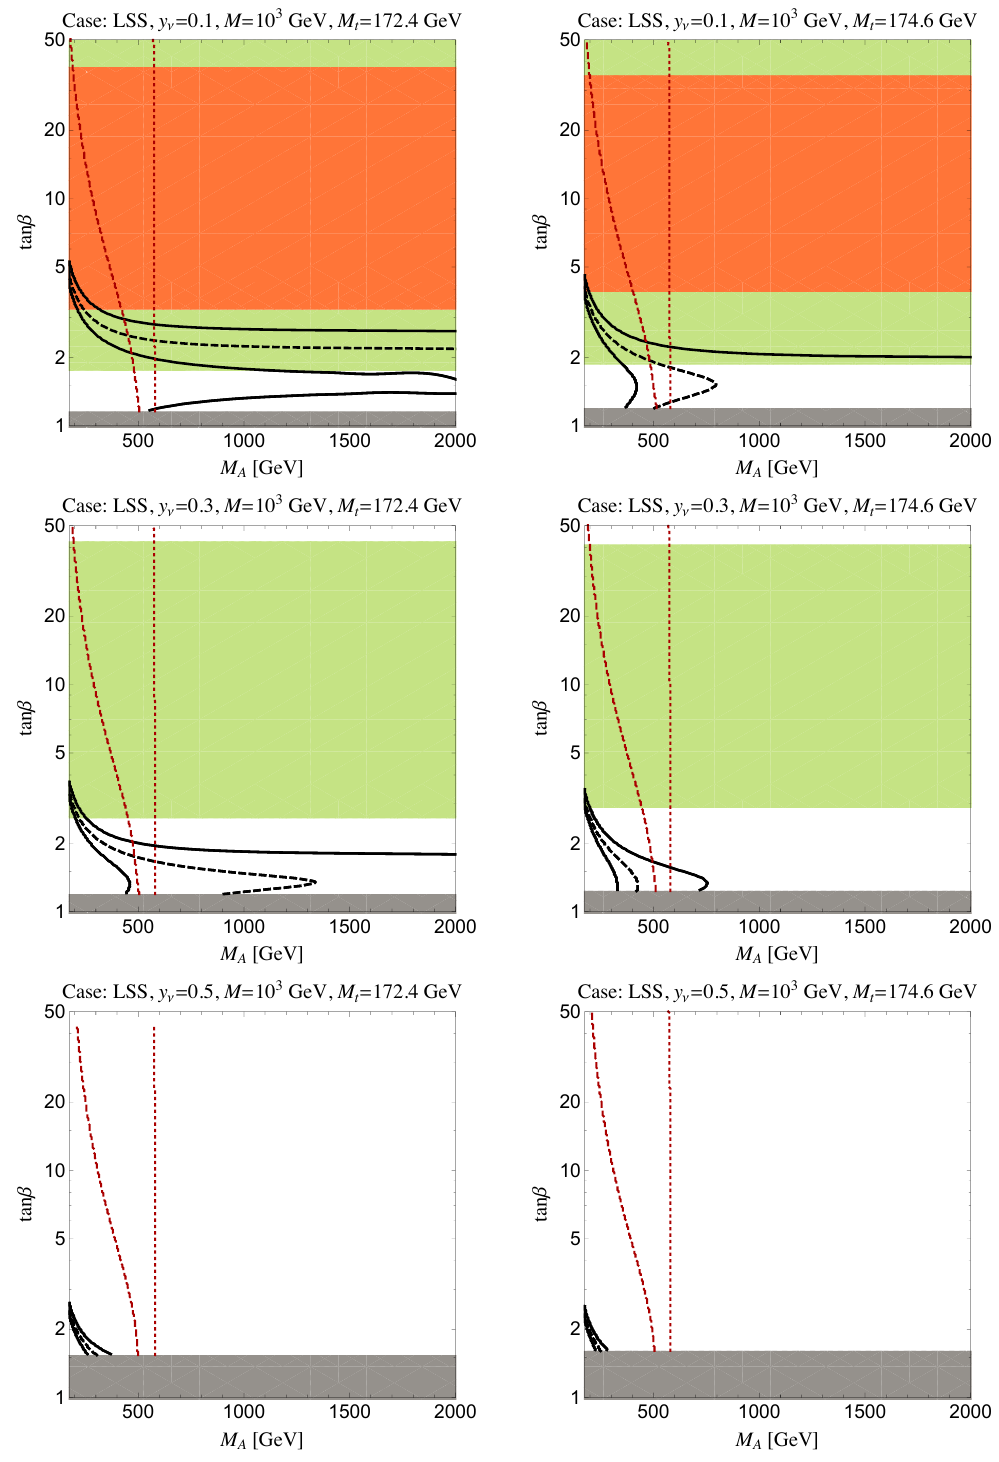
Figure 8 . The details are same as given in the caption of (cid:12)gure 1.